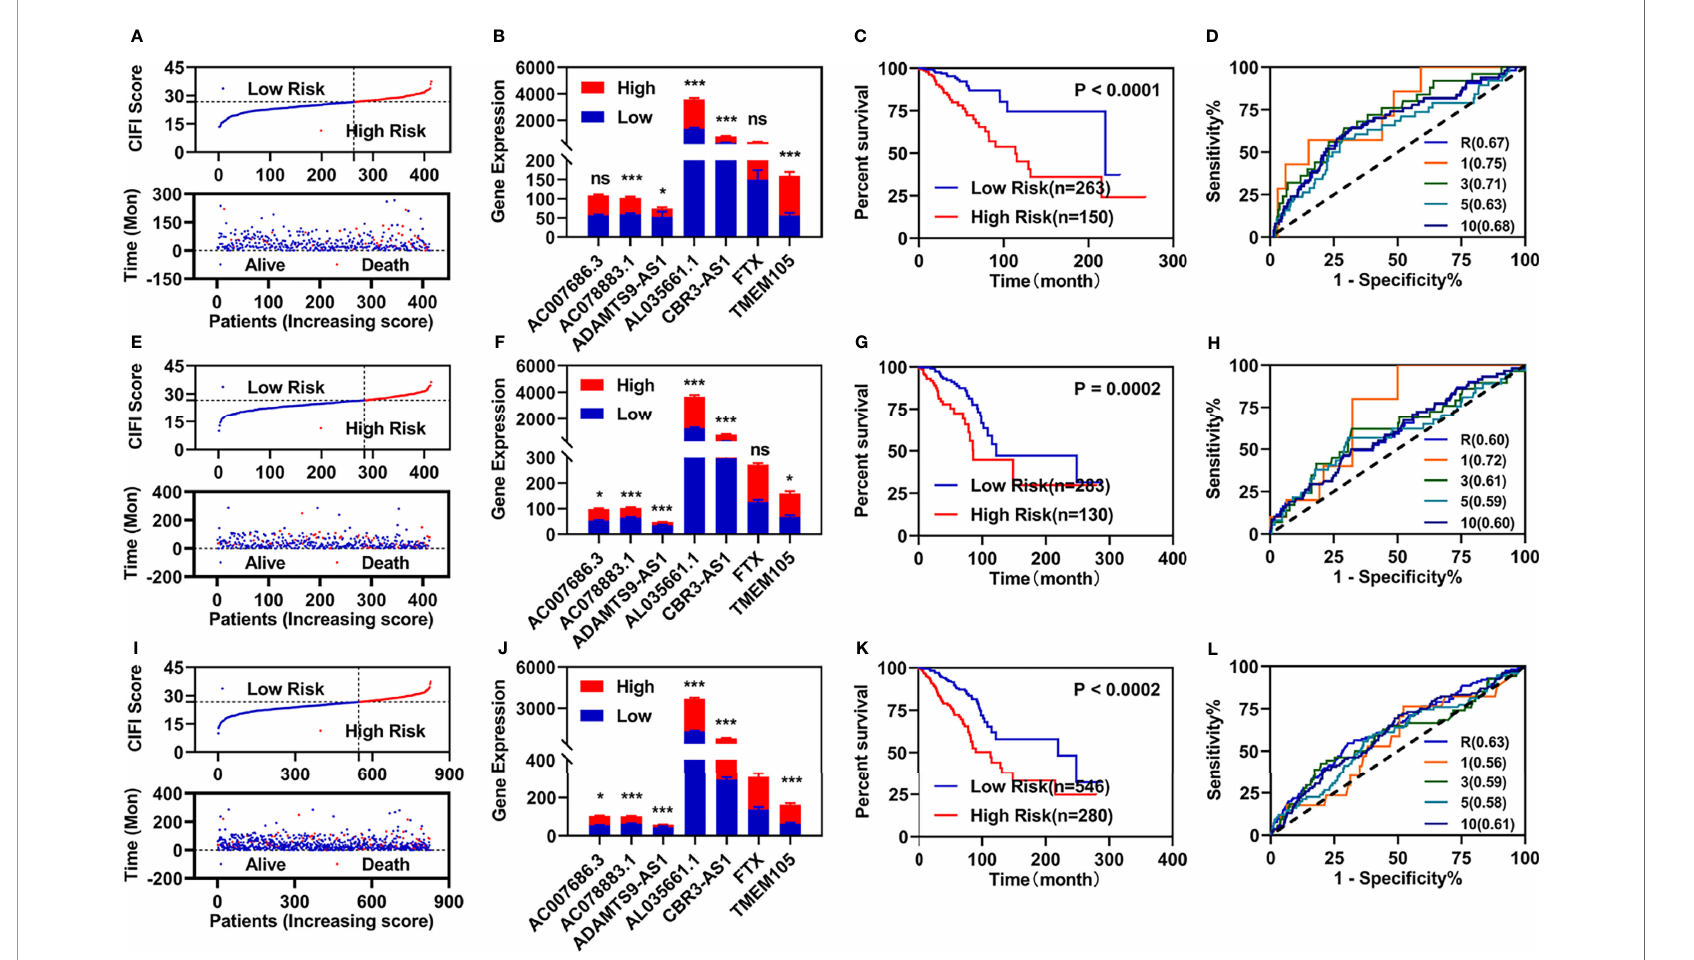
FIGURE 2 | Developments and validations of prognosis model. (A, E, I) Risk value (up) and survival status (down) for each patients in the training group (A) , validation group (E) , and entire group (I) . (B, F, J) Expression of these seven candidate biomarkers in the training group (B) , validation group (F) , and entire group (J) . (C, G, K) Overall survival curve of patients with breast in fi ltrating duct and lobular carcinoma with different risk value in the training group (C) , validation group (G) , and entire group (J) . (D, H, L) ROC curve of risk assessment model in the training group (D) , validation group (H) , and entire group (L) . *p < 0.05, ***p < 0.001. ns, no signi fi